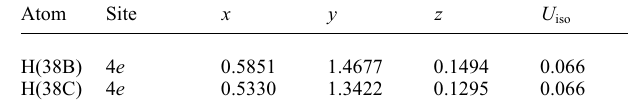
Table 3. Atomic coordinates and displacement parameters (in Å 2 )